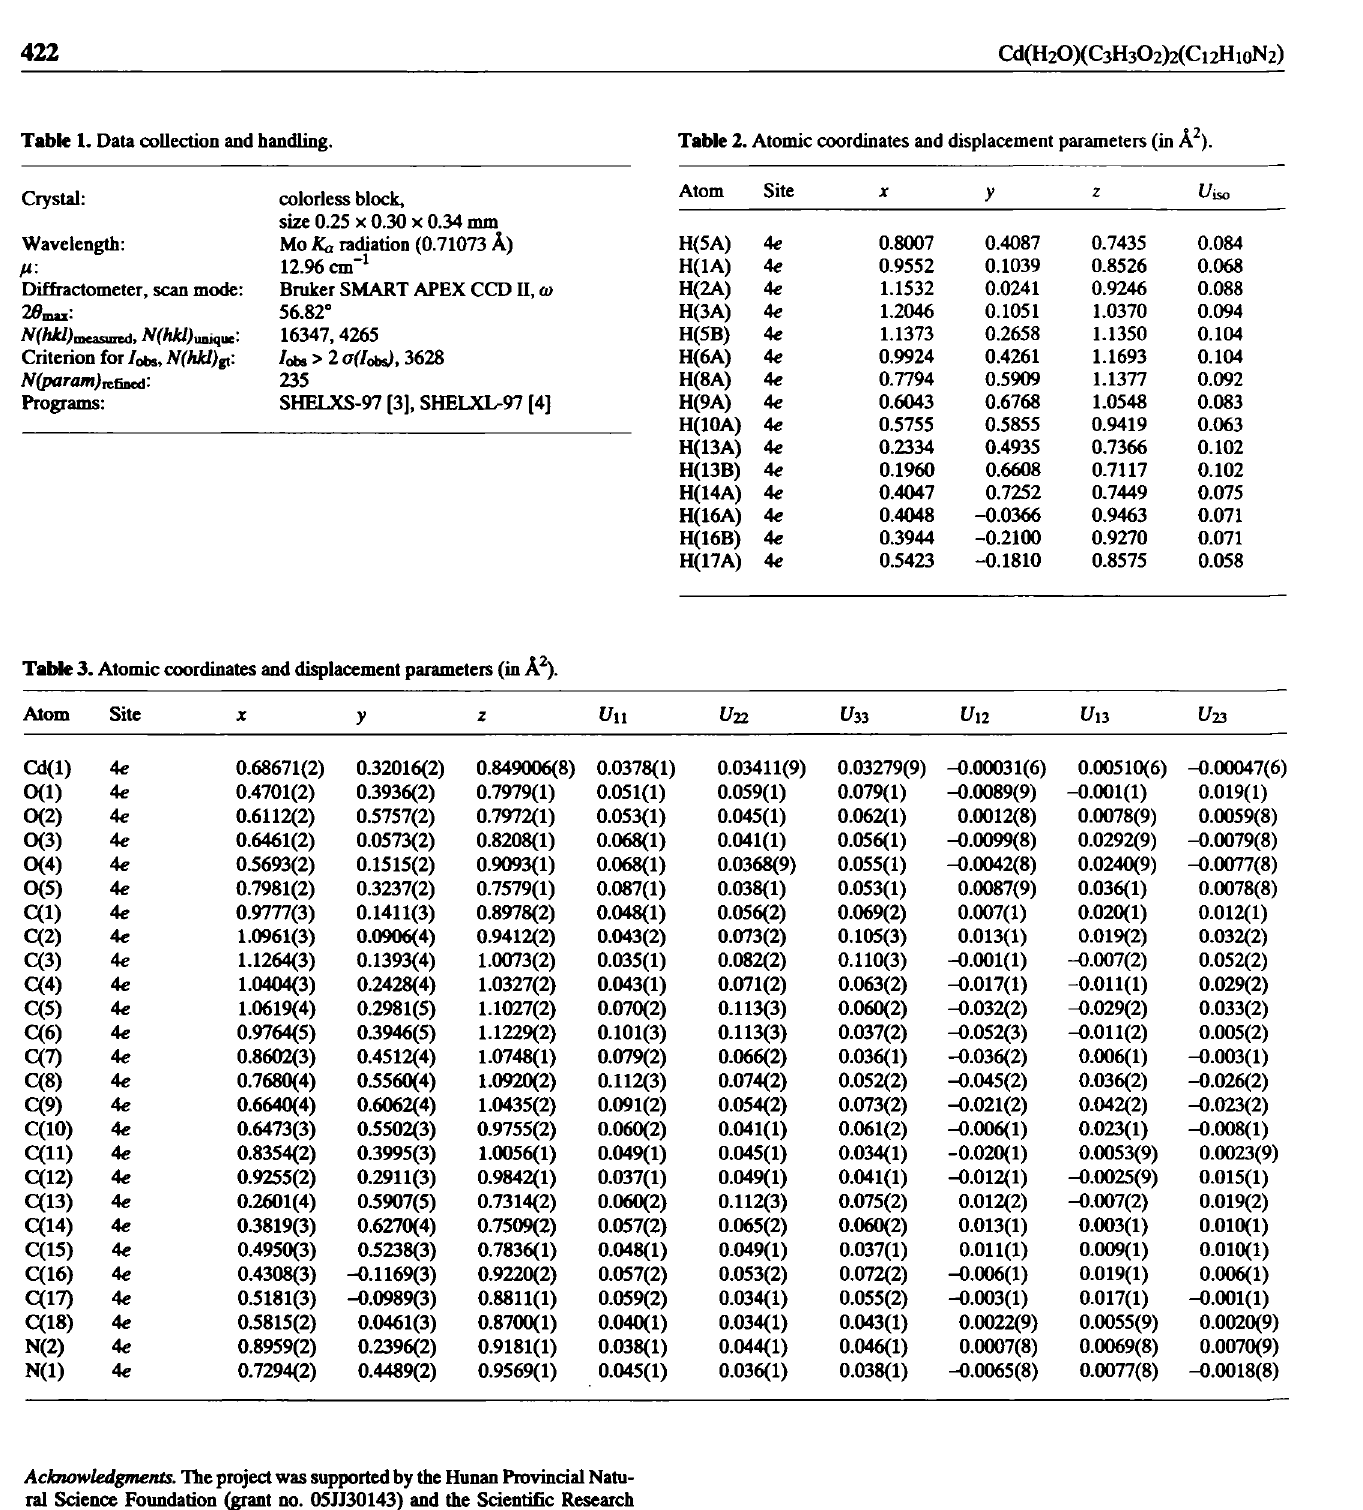
Table 1. Data collection and handling. Table 2. Atomic coordinates and displacement parameters (in A 2 ).